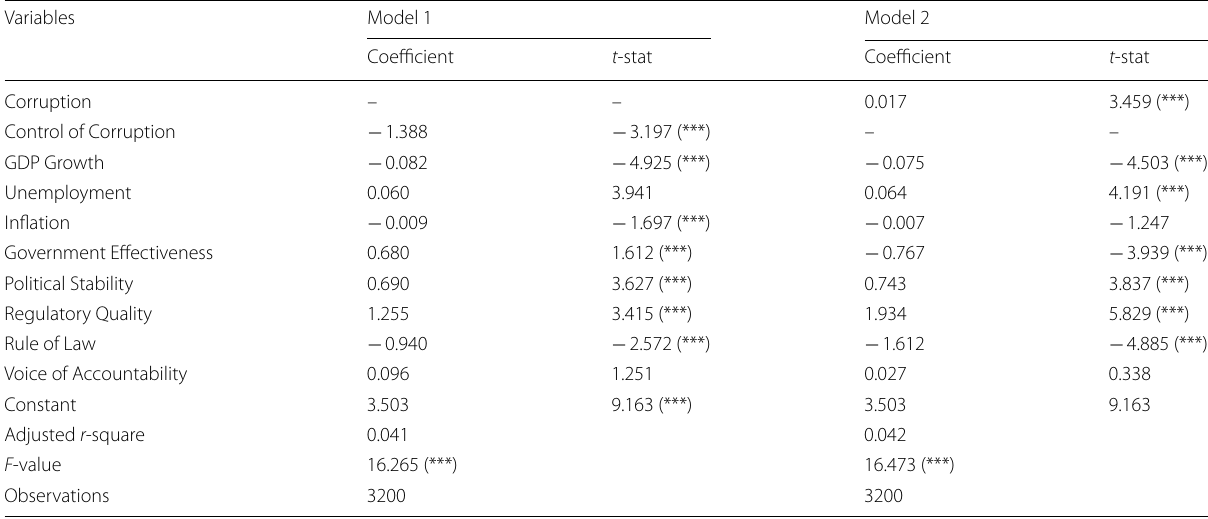
Table 9 Robustness test 2 (change of control